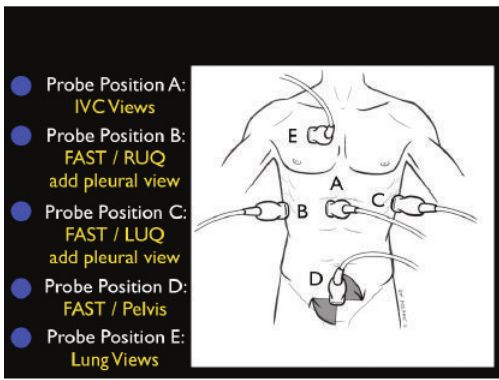
Figure 10: E-point septal separation with decreased contractility. M-mode Doppler tracing. RV: right ventricle, LV: left ventricle.